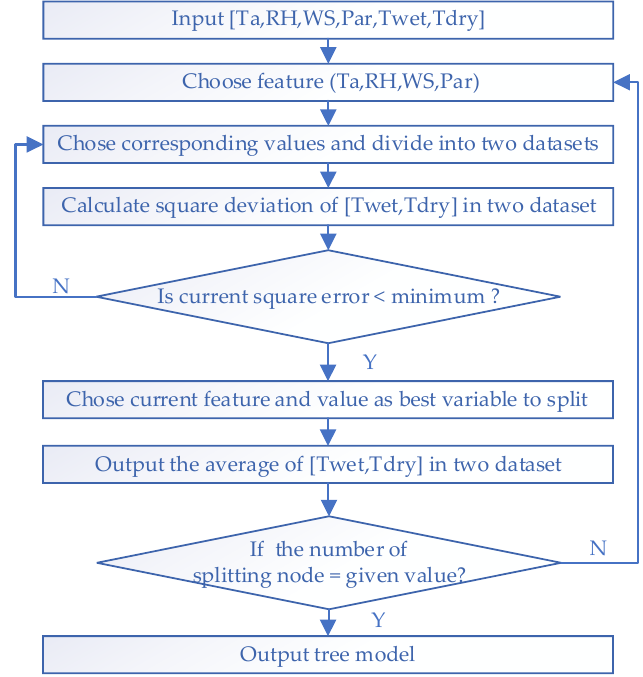
Figure 3. Flowchart of the model process used in the study.